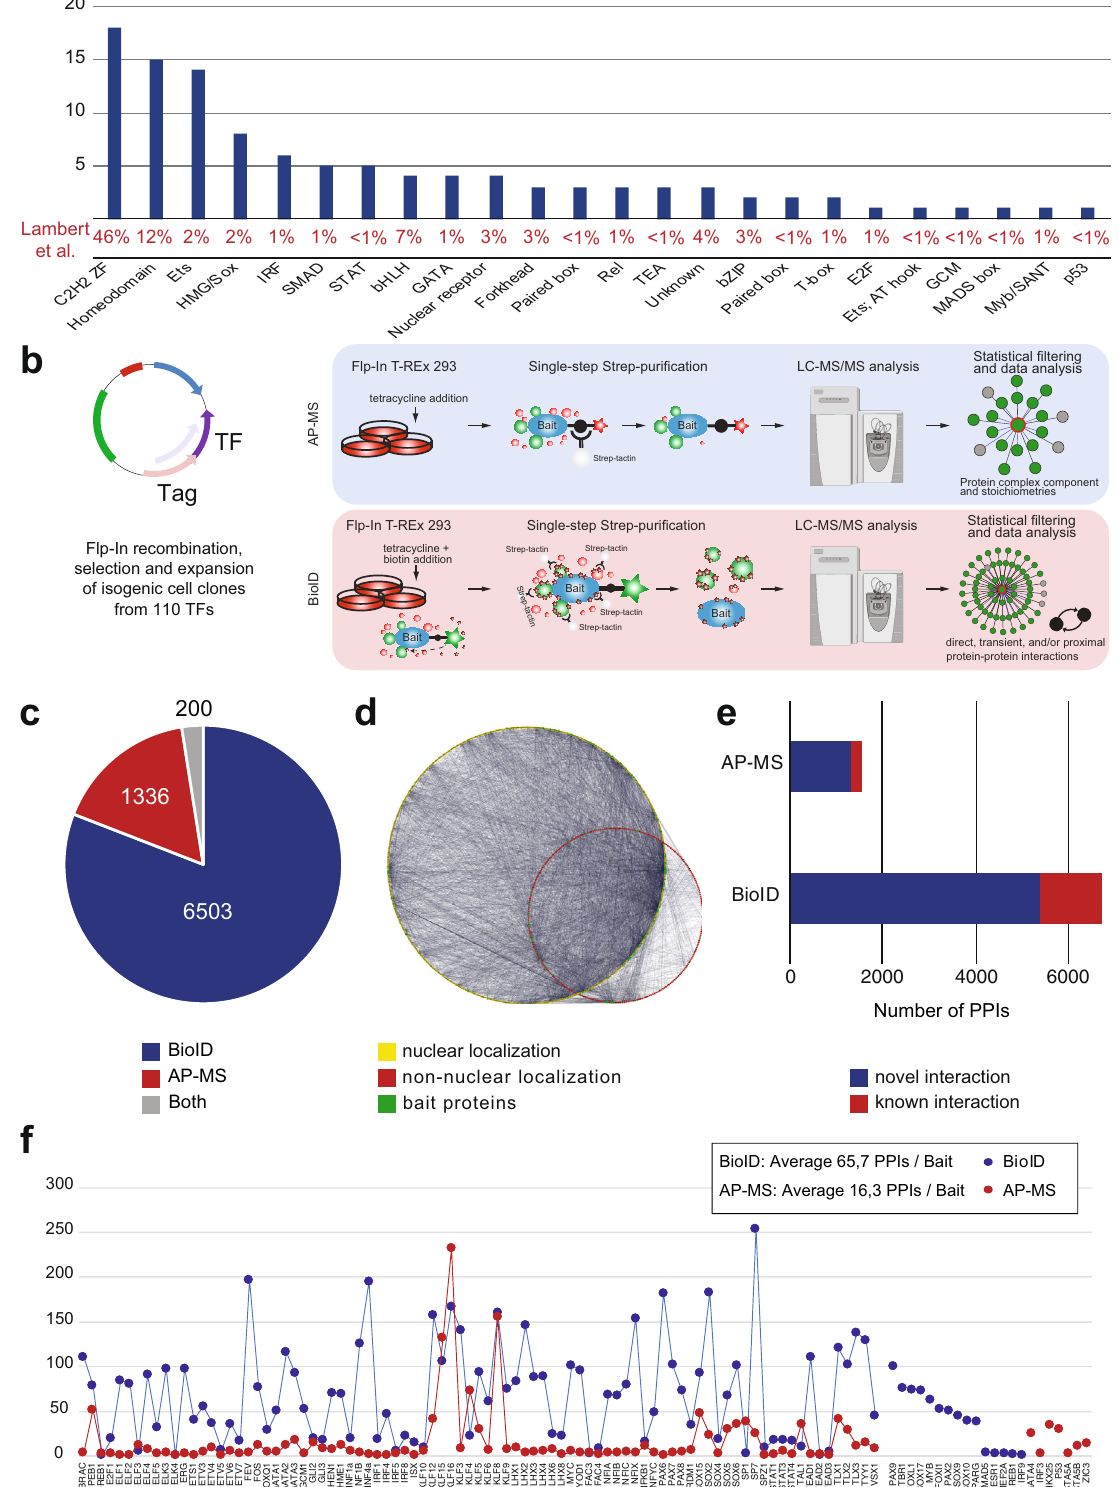
PPIs), CIC (52 PPIs), and several zinc- fi nger proteins (50 – 52 PPIs). In addition, the well-established corepressors BCOR (48 PPIs) and NCOR2 (48 PPIs) were high on the list. Not surprisingly, the most frequently observed TF interactors were transcriptional activators and repressors.